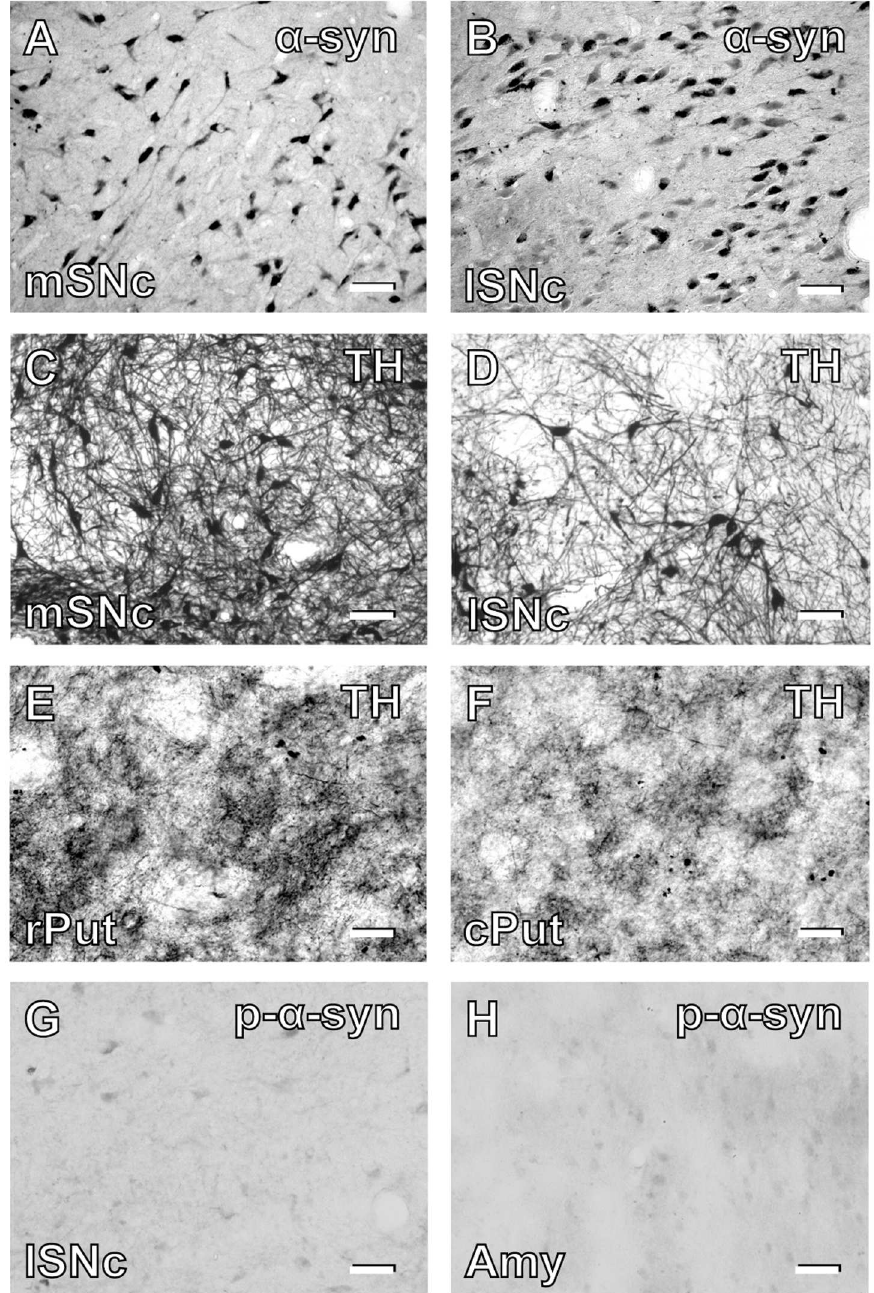
Fig 3. Photomicrographs of α -syn and TH immunostaining in the nigrostriatal dopamine systemand forebrain structuresat 31 yearsof age. A: α -Syn-positive neuronsin the medial part of the SNc (mSNc). B: α -Syn-positive neuronsin the lateral part of the SNc (lSNc). C: TH-positive neuronsin the mSNc. D: TH- positive neuronsin the lSNc. E: TH-positive fibers and terminals in the rostral aspect of the putamen(rPut). F: TH-positive fibers and terminals in the caudalaspect of the putamen(cPut). G: Phosphorylated α -Syn immunostaining in the lSNc. G: Phosphorylated α -Syn immunostaining in the amygdala(Amy). Scale bars, 50 μ